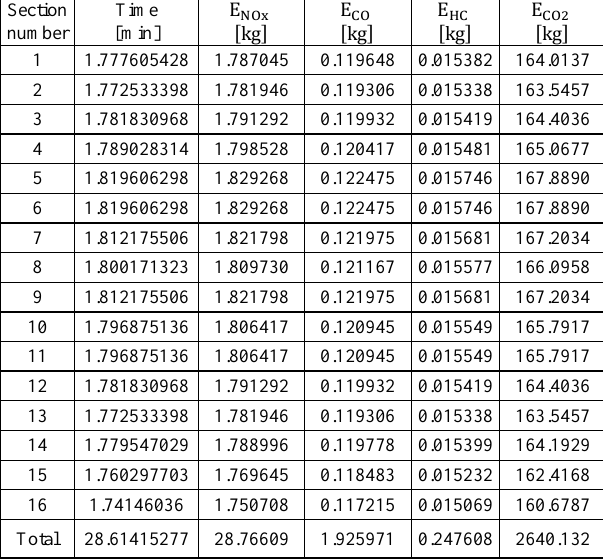
Table 3. Emission of NO x , CO, HC and CO 2 in the exhausts of Gulfstream IV in each section of the flight from Rzeszow to Gdansk with the time